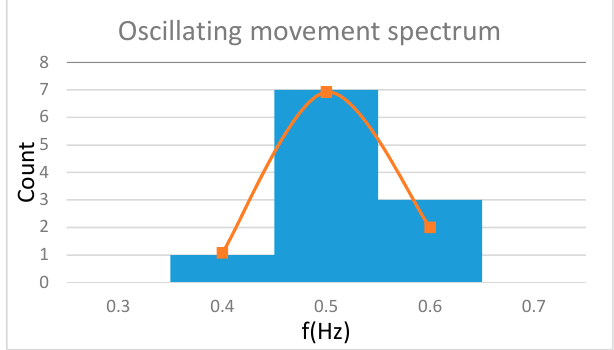
Figure 3. Mean range of frequency of center of pressure (COP)-track along the x-axis.